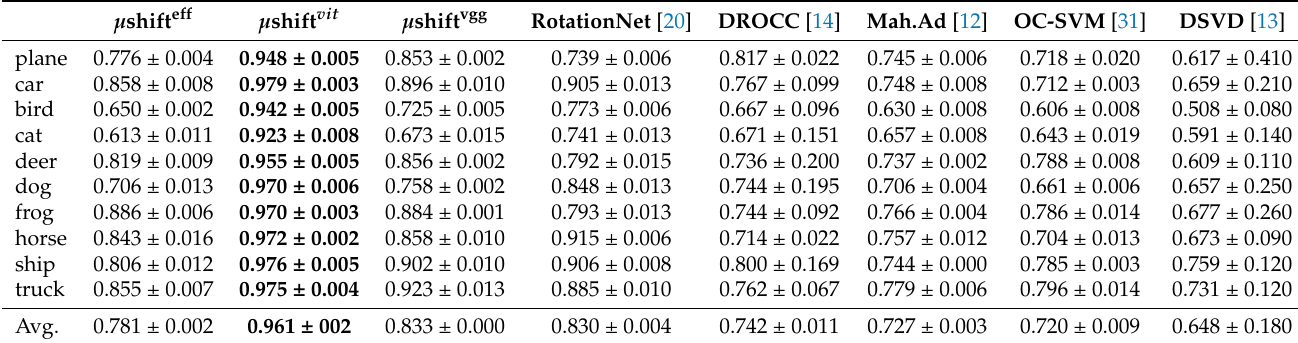
Table 1. Evaluating detection capabilities of globally distributed novelty on the CIFAR-10 dataset using five-fold cross-validation. Changing the CNN feature space impact the detection performance significantly. We argue that this indicates a strong correspondence between novelty size and the size of the receptive field of the CNN